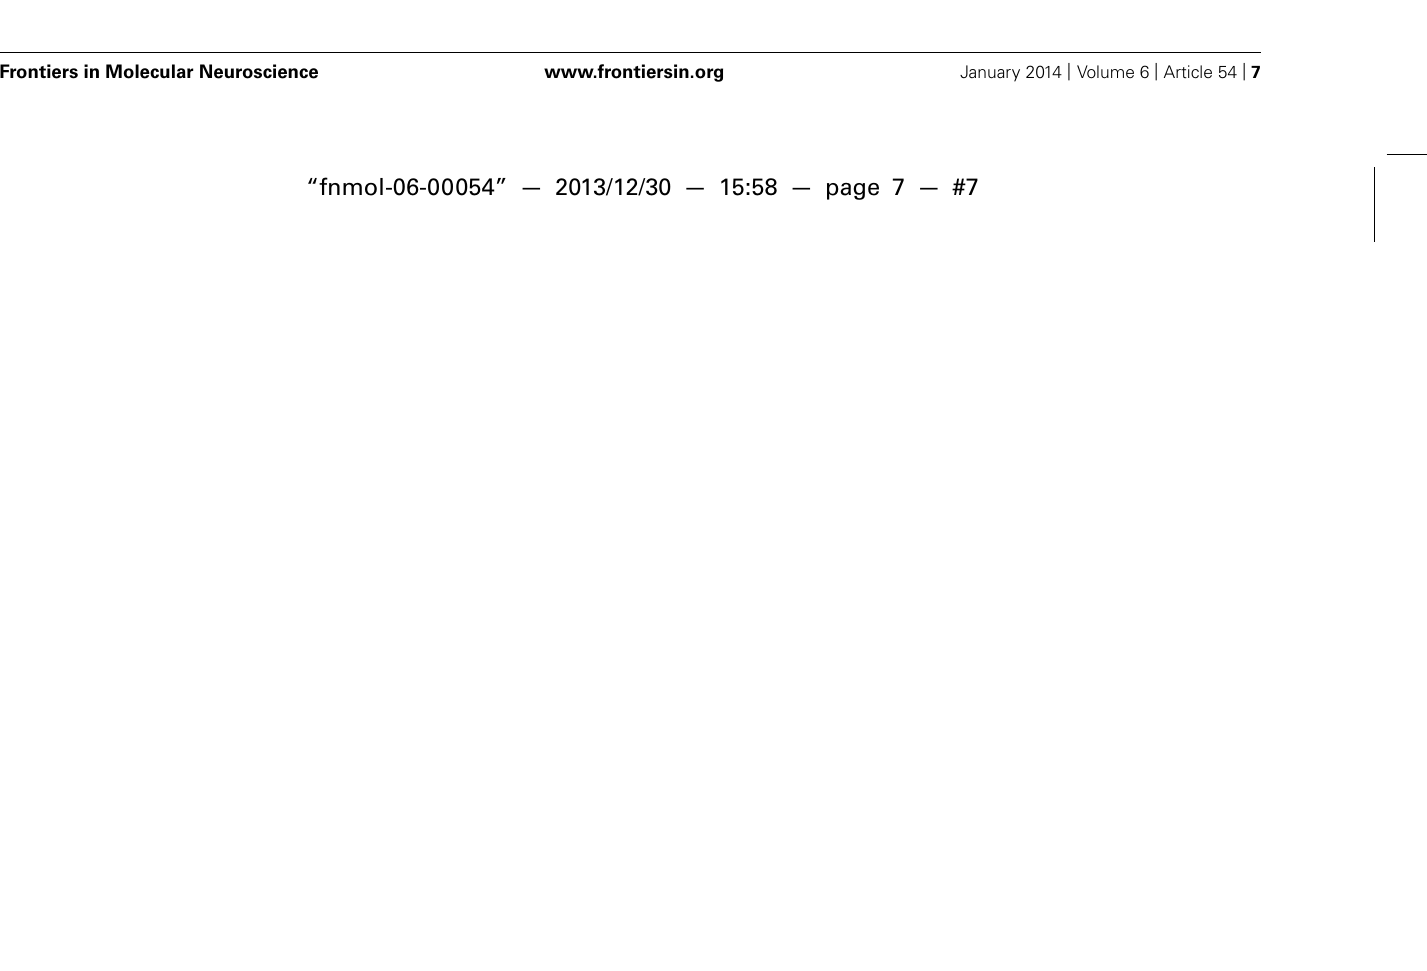
was not statistical difference between them. Control animals in CFC conditions are animals that underwent the CFC test but were injected with the